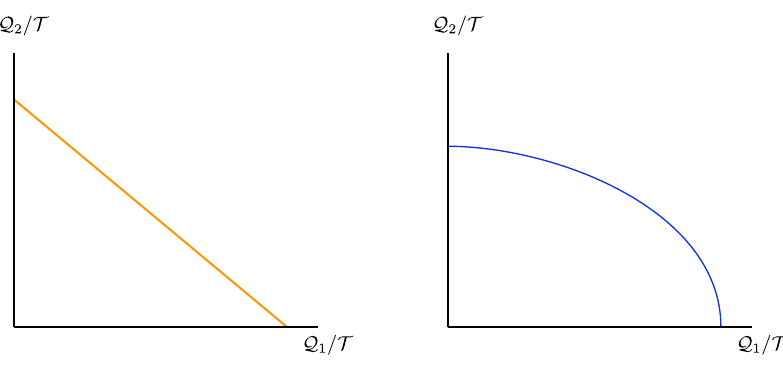
Figure 4 . Extremal region for mutually BPS (left) and non-mutually BPS states